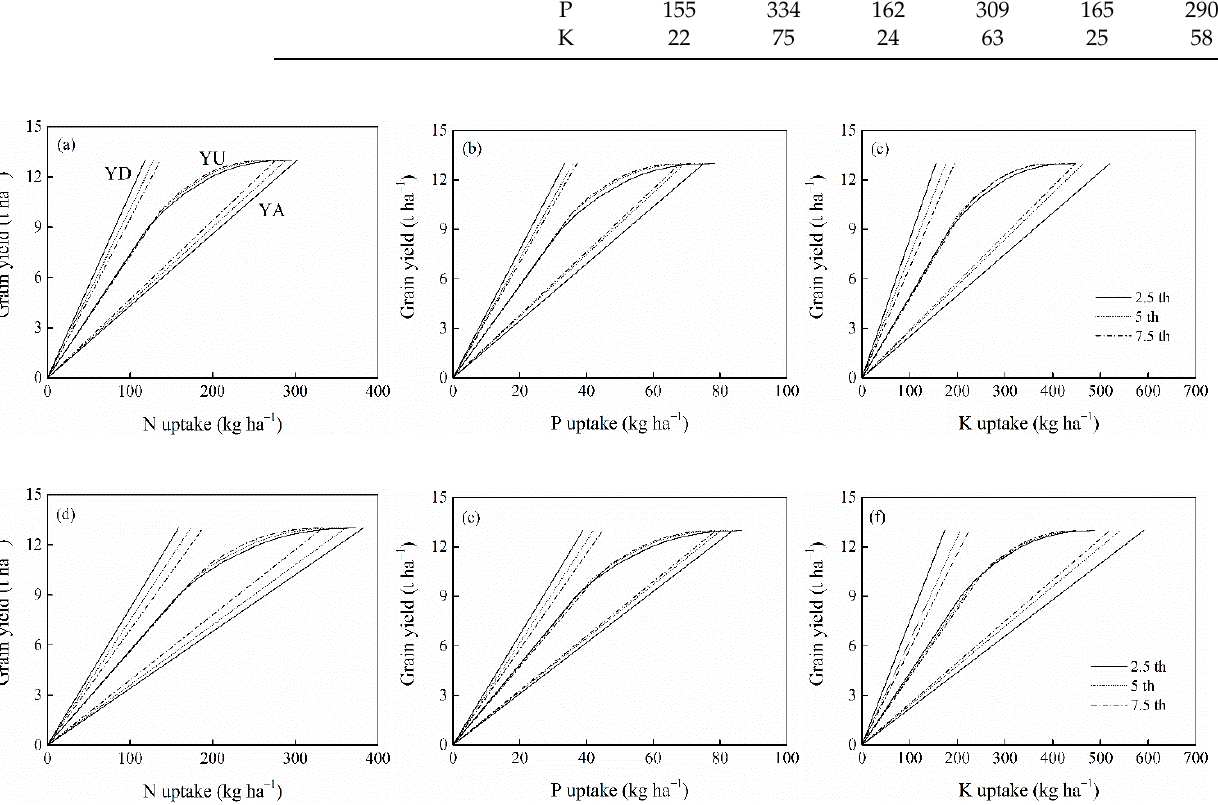
Figure 3. The nutrient requirements of japonica/indica hybrid rice ( a – c ) and japonica rice ( d – f ) simulated by the quantitative evaluation of the fertility of tropical soils (QUEFTS) models based on Set I, Set II, and Set III (HI ≥ 0.4 kg kg − 1 ). The yield potential of rice was set at 13 t ha − 1 . YD, YU, and YA represent the maximum dilution, balanced uptake of nutrient in plant dry matter, and maximum accumulation, respectively.